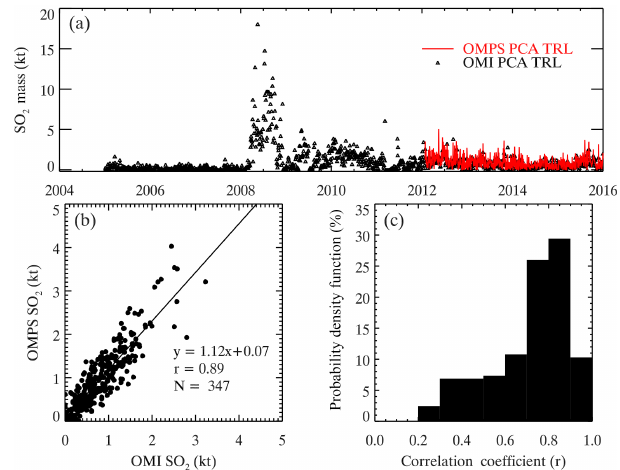
Figure 7. (a) Daily total SO 2 mass in a domain (16–21 ◦ N, 154– 160 ◦ W) around the K¯ılauea volcano in Hawai’i, retrieved with OMI and OMPS using the PCA algorithm assuming a lower tropospheric (TRL) SO 2 profile. Only days with at least 90% coverage of the domain by either OMI (the first 24 rows) or OMPS (all 36 rows) are shown. (b) Scatter plot between OMI- and OMPS-estimated total SO 2 over the domain for days with at least 90% spatial coverage by both OMI (the first 24 rows) and OMPS. (c) The probability density function of the daily spatial correlation coefficient between OMI and OMPS TRL SO 2 , both gridded at 0.5 ◦ × 0.5 ◦ resolution. Only those days ( ∼ 200 in all) when both instruments covered over 90% of the domain and detected over 0.5kt of SO 2 are